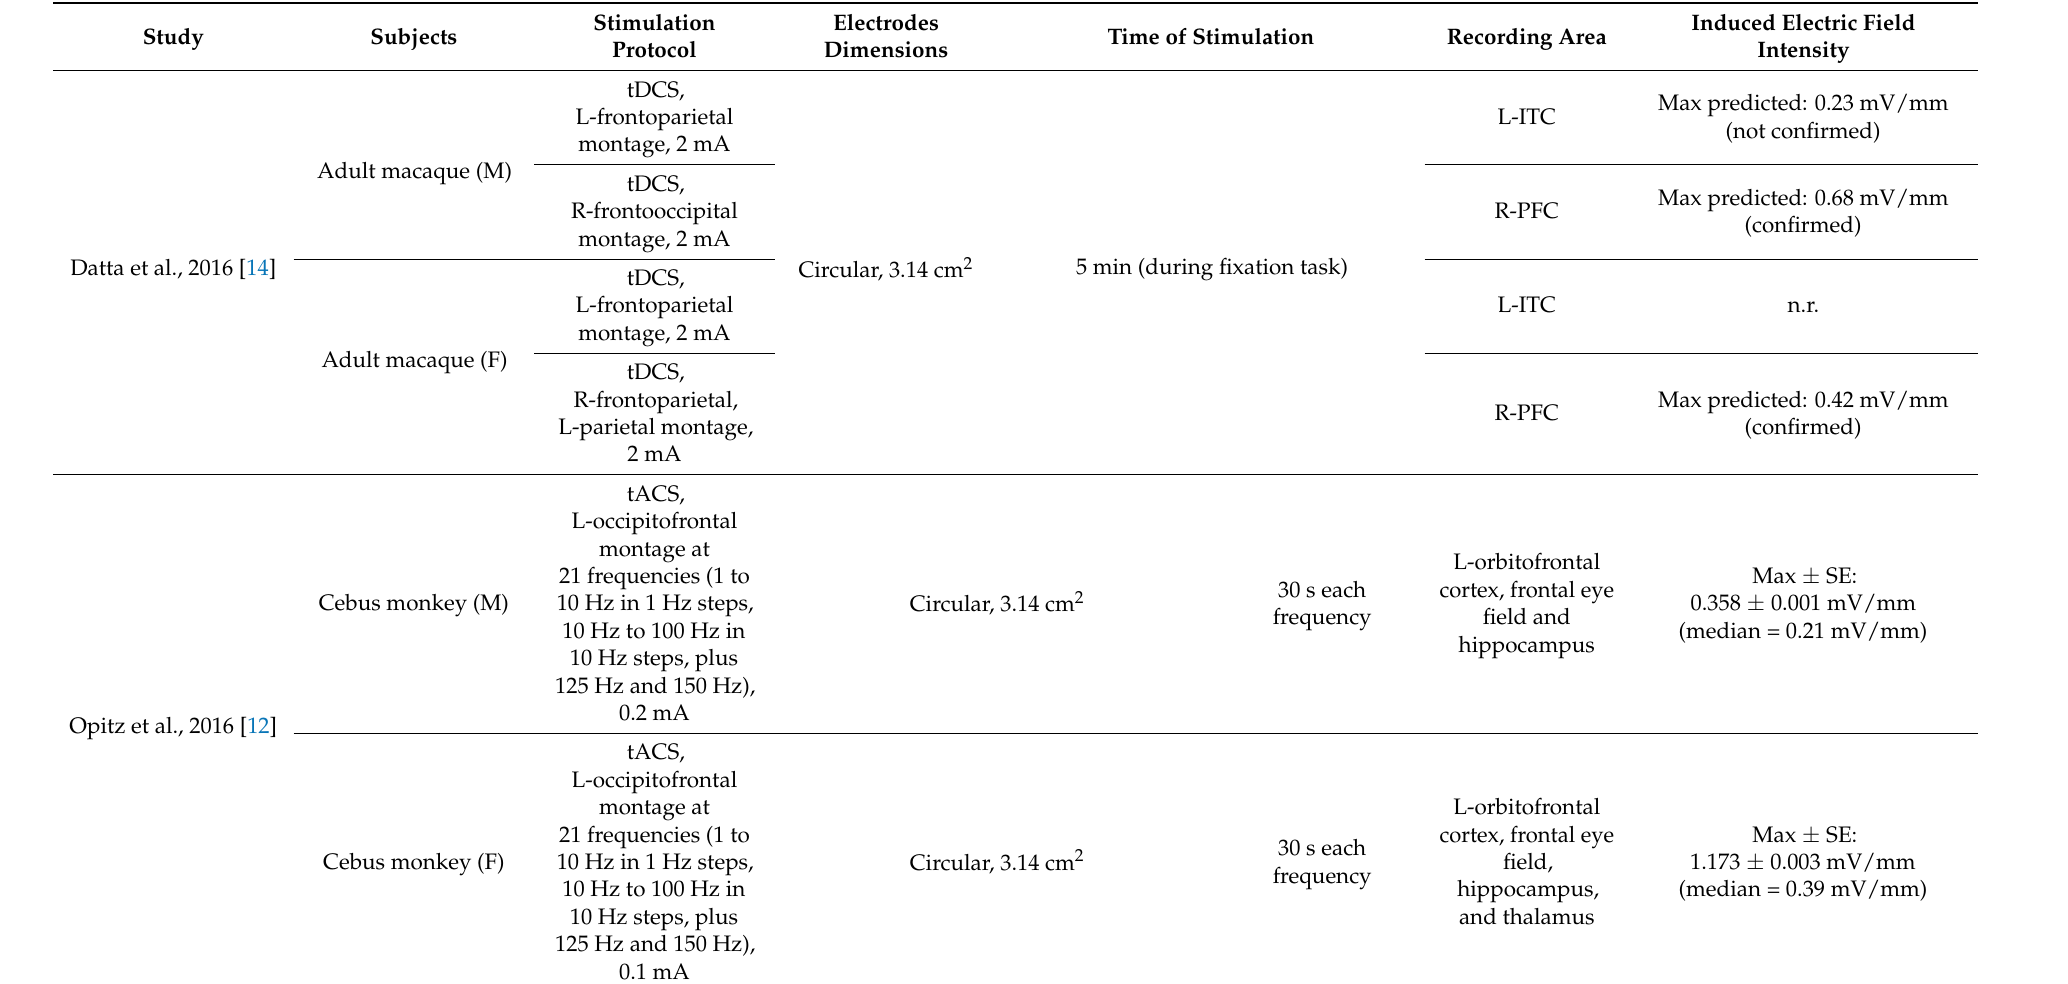
Table 4. Overview of the studies recording electric field during tACS and tDCS in humans and